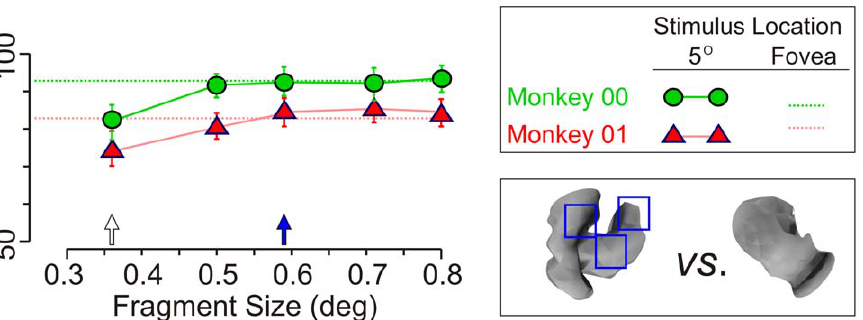
Figure 9. Effect of M-scaling on categorization performance in Experiment 3. The animals performed a fragment-based categorization task where the sample stimulus in each trial was a fragment and the test stimulus was a whole object. All stimuli were presented at an eccentricity of 5 u in the lower right quadrant. The performance of the animals for Main fragments is shown as a function of the fragment size. The performance for the Control fragments was at chance levels, as expected (not shown). For any given size, all stimuli, including all whole objects and fragments, were magnified by the same scaling factor. See Materials and Methods for details. The open arrow denotes the original size of the fragment ( i.e ., without magnification). The filled blue arrow denotes the M-scaled size appropriate for 5 u . The dotted horizontal lines denote the performance of either animal when the stimuli were viewed foveally at their original, unmagnified size. Typical objects from the Main class and Control class are shown in the bottom right inset, with three selected Main fragments highlighted by blue squares on the object from the Main class.